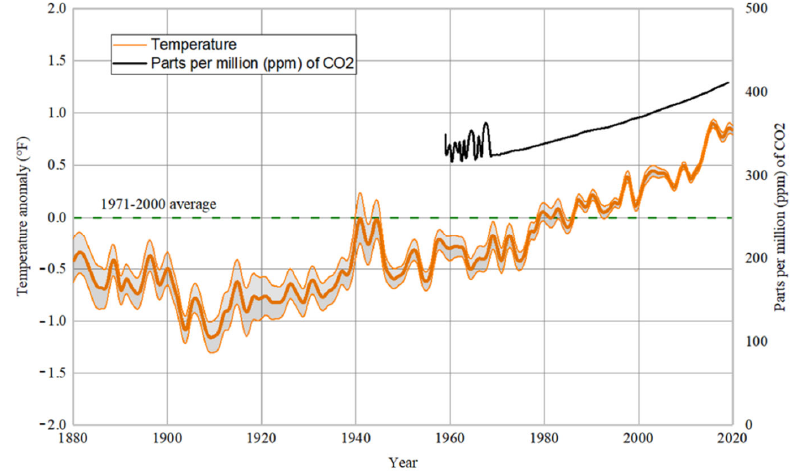
Figure 5. Ocean surface temperature (1880–2020) and the concentration of carbon dioxide in the air (1950–2020).